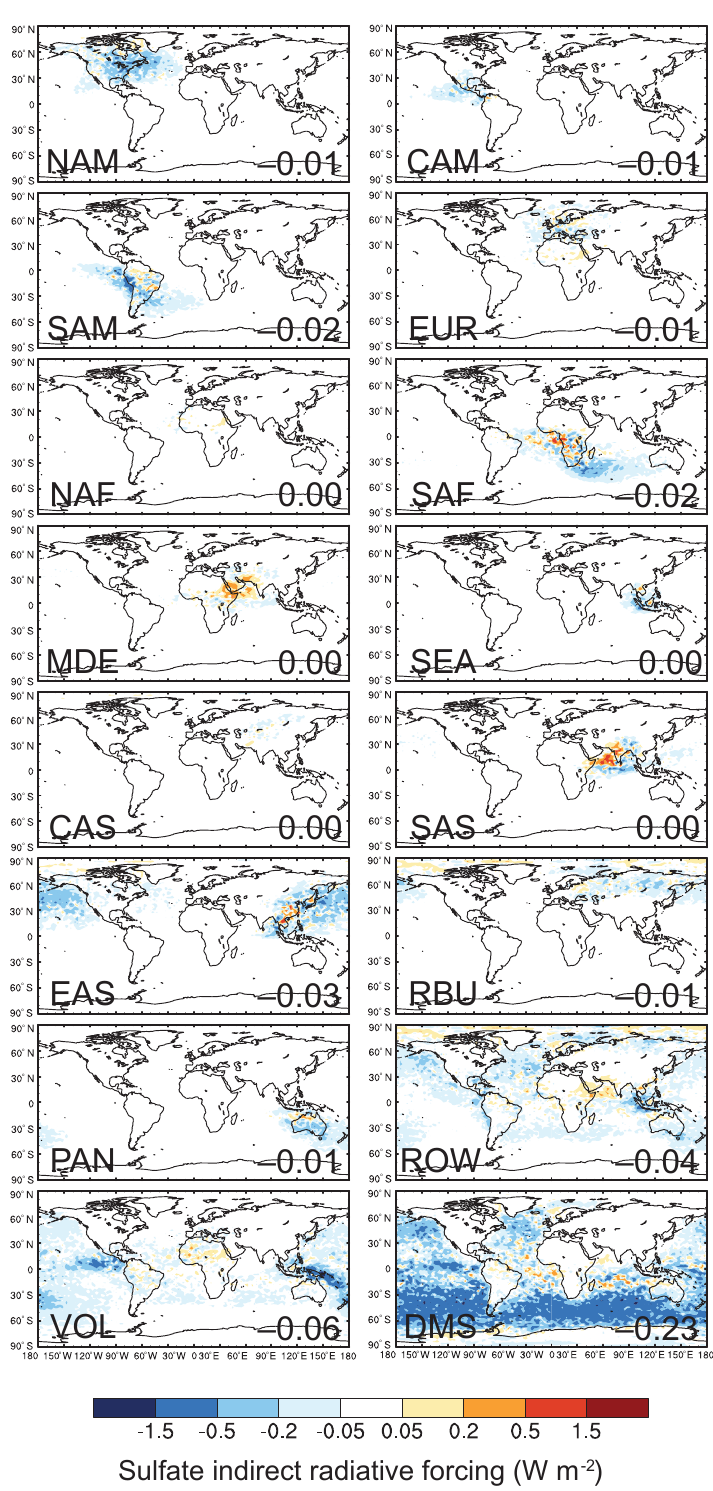
Figure 10. Spatial distribution of responses of annual mean indirect radiative forcing of sulfate (IRF, Wm − 2 ) to a 20% reduction in sulfur emissions (standard simulation – simulation with 20% emission reduction). Regional contributions are calculated as a scaled total incremental IRF in each grid cell by the ratio of the source contribution to total sulfate mass concentration reduction averaged from the surface layer to 850hPa. Regional mean contributions to global incremental IRF of sulfate are shown at the bottom right of each